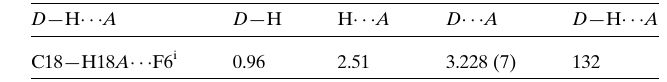
Table 1 Hydrogen-bond geometry (A˚ , (cid:4) ).